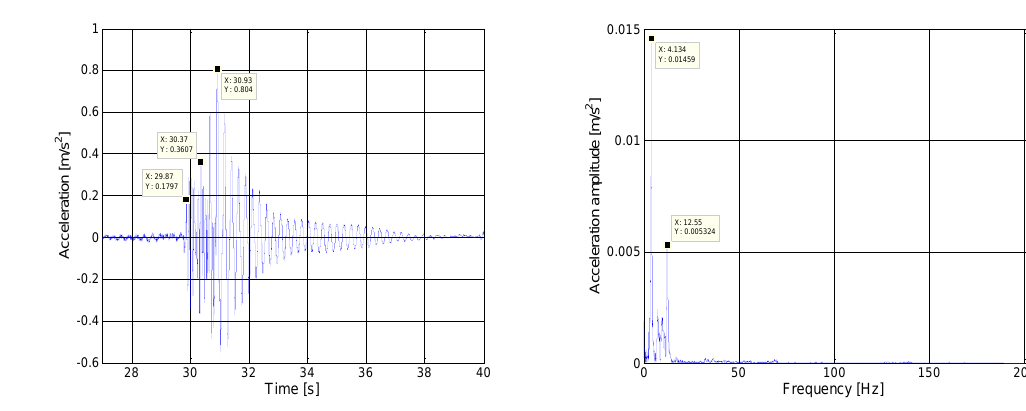
Fig. 29. Acceleration on OZ direction. Fig. 30. Spectral